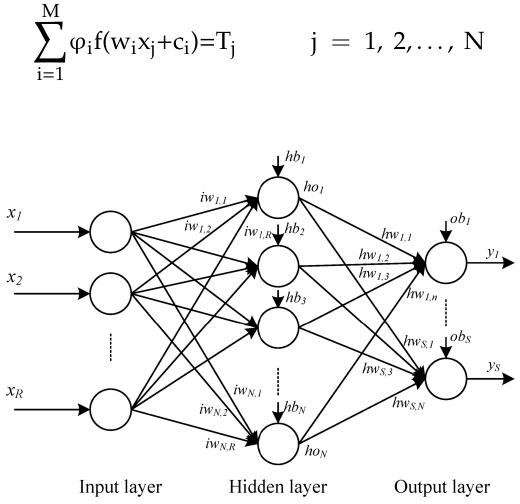
Figure 1. Single hidden Layer Feedforward Neural network.